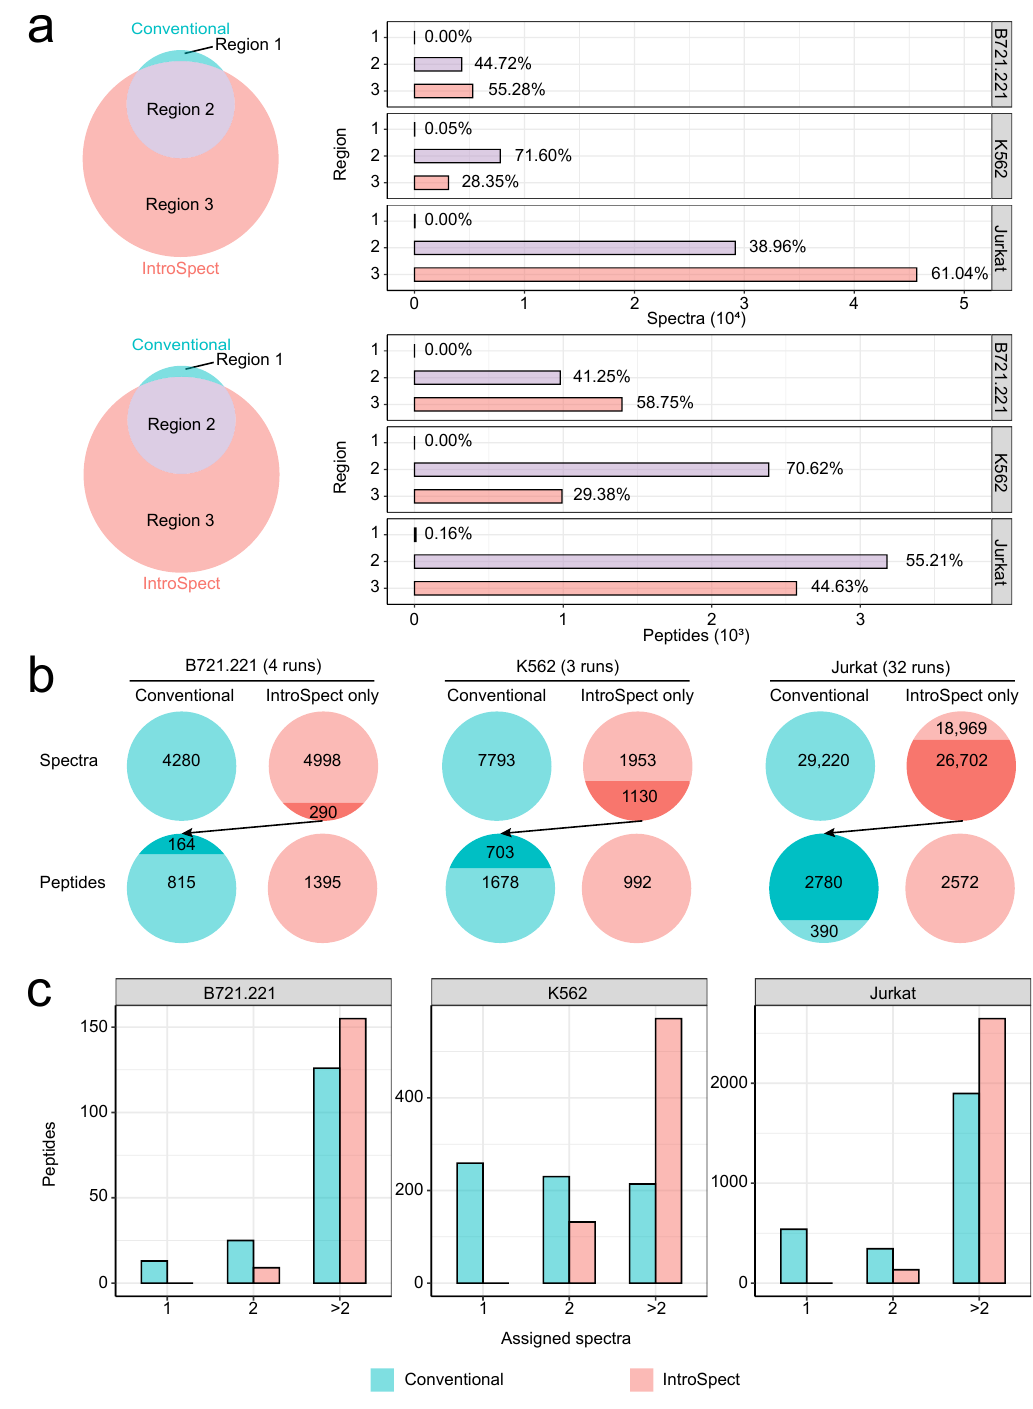
Figure 3. The high consistency of identified spectra and peptides between conventional and In- troSpect search. ( a ) Most of the spectra (top panel) or immunopeptides (bottom panel) detected by conventional method can be identified through IntroSpect. Regions 1, 2 and 3 denote spectra (top panel) or immunopeptides (bottom panel) detected by conventional only, both, or IntroSpect only. The percentages are calculated based on the total number of peptides or spectra identified by both methods. The gray boxes on the right panel denote cell lines. ( b ) A fraction of spectra newly identified by IntroSpect were matched to peptides previously identified by conventional search (refined peptides). These refined peptides were indicated in dark shades. ( c ) The number of assigned spectra for refined peptides increased